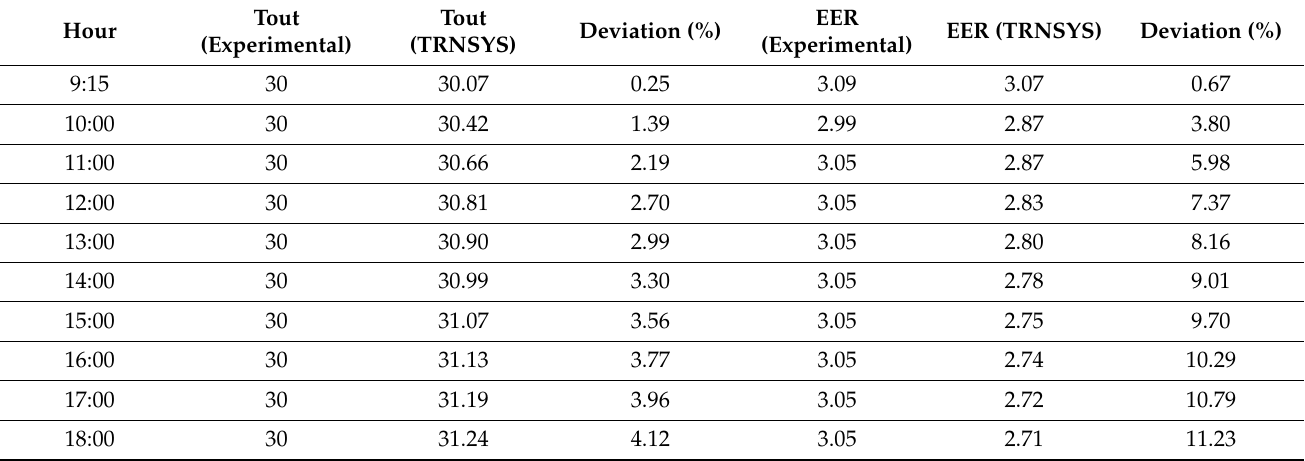
. Figure 11. Comparison between simulated and experimental results of temperature and EER at a flow rate of 2GPM. Figure 12. Comparison between simulated and experimental results of temperature and EER at a flow rate of 3GPM. The average deviation of the simulator for the GHE outlet temperature corresponds to a value of 2.77% and 3.7% for the EER of the GHP. The average percentage error of the GHE outlet temperature with a flow of 1, 2, and 3 GPMs corresponds to 0.4%, 1.84%, and 2.82%, respectively. On the other hand, the deviation for the EER with a flow of 1, 2, and 3 GPMs corresponds to 0.5%, 2.9%, and 7.7%, respectively. 4.3. Temperatures and Electrical Consumption Continuous experimentation was carried out during the year 2020 in the experi- mental greenhouse, taking the readings of the internal temperature of the greenhouse, the temperature of the subsoil, and the thermal power in heating and cooling mode, as well as the electrical consumption of the GHP. This study was carried out with the purpose of